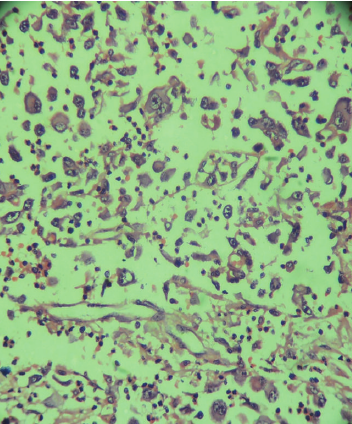
Figure 1: The tumor was composed of large sized, bizarre shaped cells with ample dense eosinophilic cytoplasm and highly pleomor- phic vesicular nuclei with prominent nucleoli, without showing any organoid pattern. Multiple mitotic figures and neutrophilic infiltrate are also seen (H&E stain 100x).